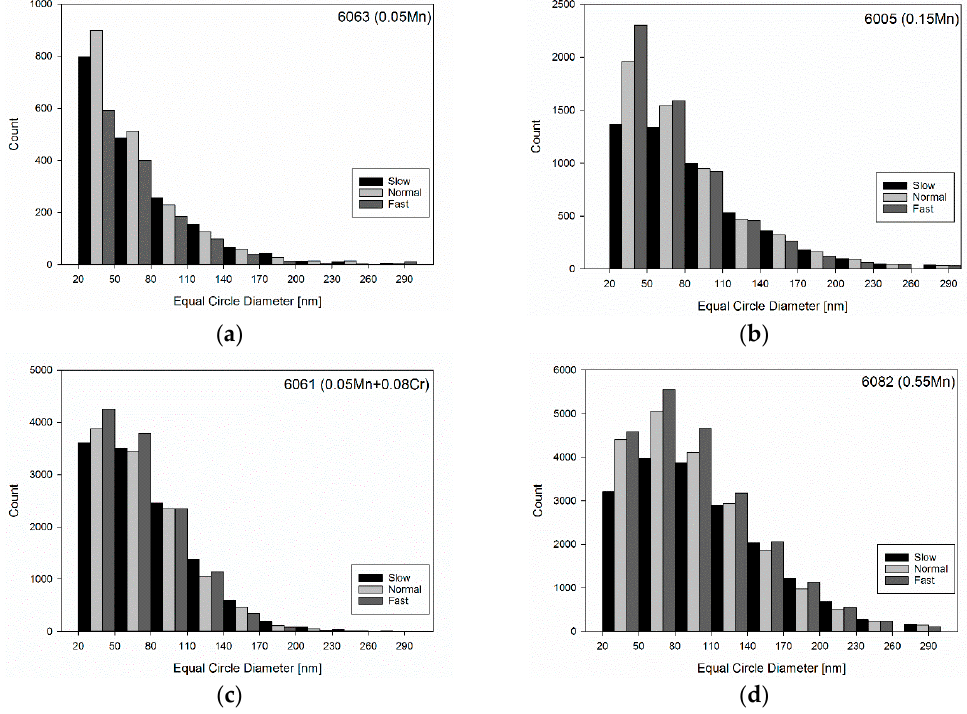
Figure 14. Particle size distribution as a function of heating rate. ( a ) 6063, ( b ) 6005, ( c ) 6061, ( d ) 6082. Note the different scales along the ordinate axes.